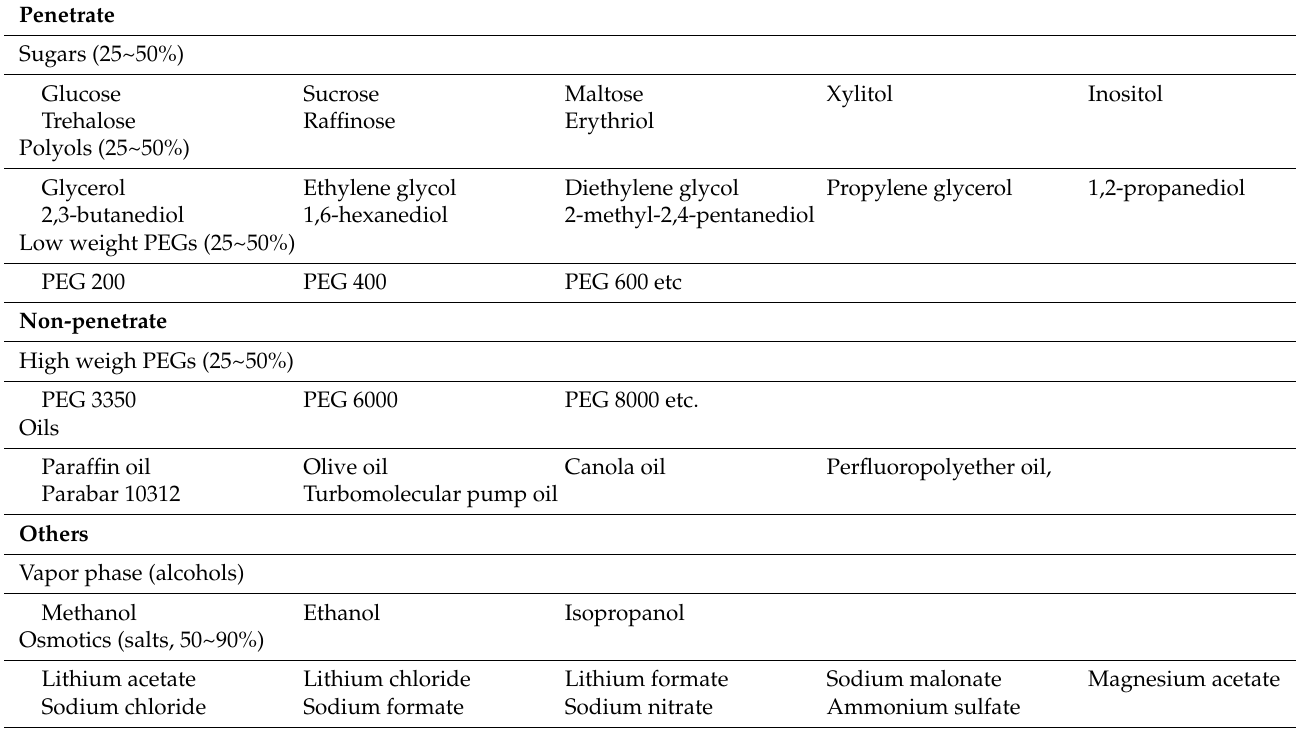
Table 1. The types of